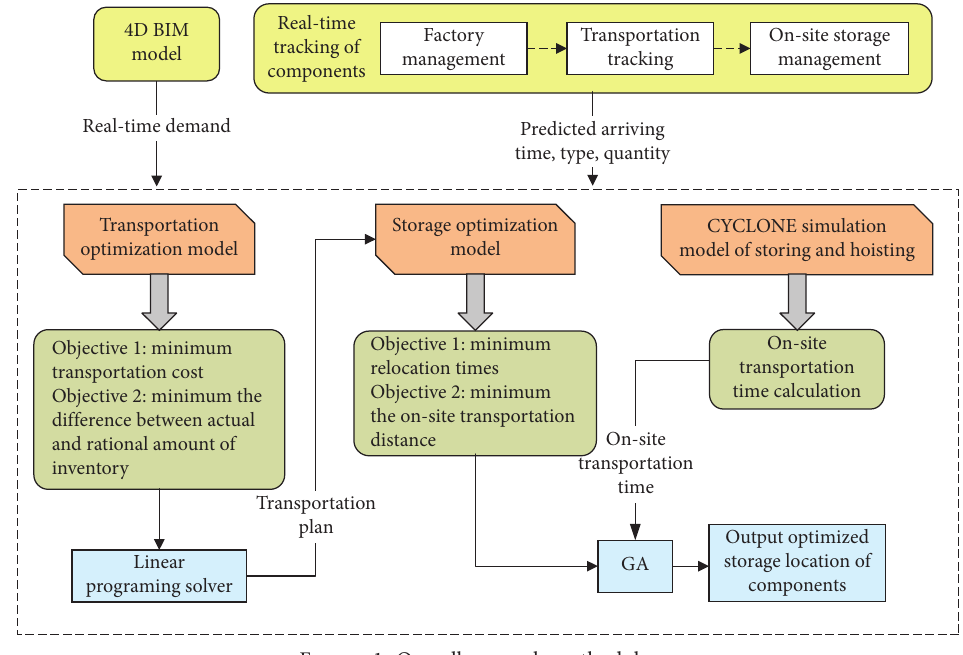
Figure 1: Overall research